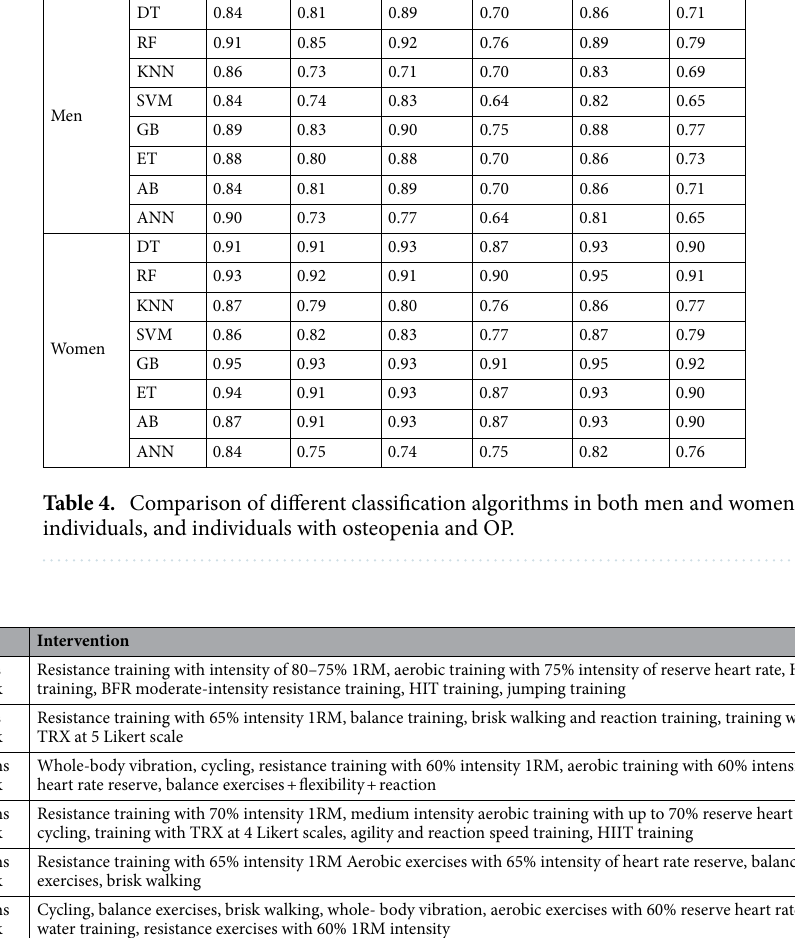
Models AUROC Accuracy Precision Sensitivity specificity F-score